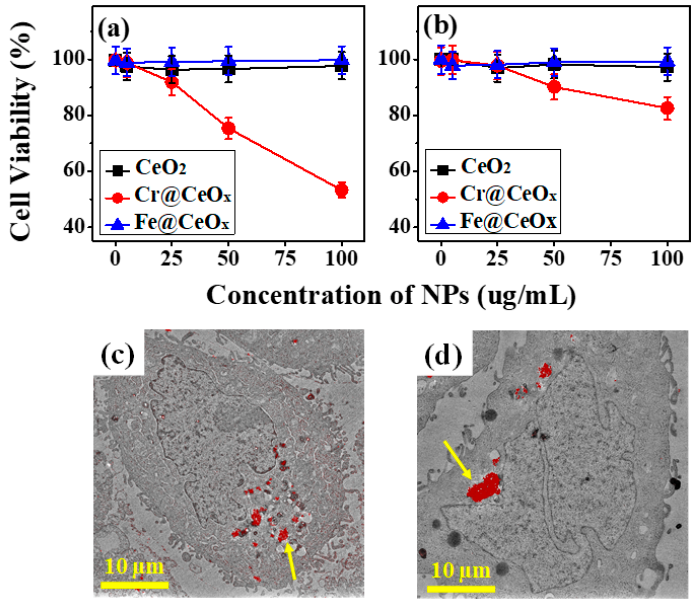
Figure 4. Quantification of the cytotoxicity of the nanoparticles (NPs) using MTT and NRU assays. HaCaT cells were treated with CeO 2 , Cr@CeO x , and Fe@CeO x NPs at concentrations of 5 and 100 µ g / mL for 72 h. ( a ) MTT assay and ( b ) NRU assay. Bio-TEM data (red color: NPs). Cr@CeO x NPs are shown in ( c ), while Fe@CeO x NPs are shown in ( d ). Arrow indicates the position of nanoparticles.